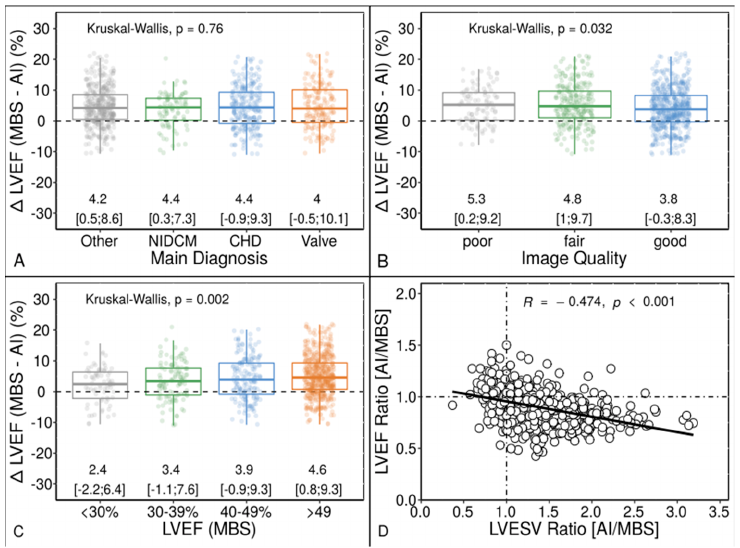
3.4. Agreement and Bias Categorized Using Clinical and Echocardiographic Characteristics Among patients with non-ischemic cardiomyopathy, coronary heart disease and val- vular heart disease, we found no significant difference in LVEF bias between AI and MBS when compared to the overall cohort (Figure 3). The corresponding distribution of main clinical and echocardiographic characteristics is summarized in Table 3. However, the in- ter-method bias of LVEF decreased with improving image quality but increased with im- proving left ventricular function (Figure 3).